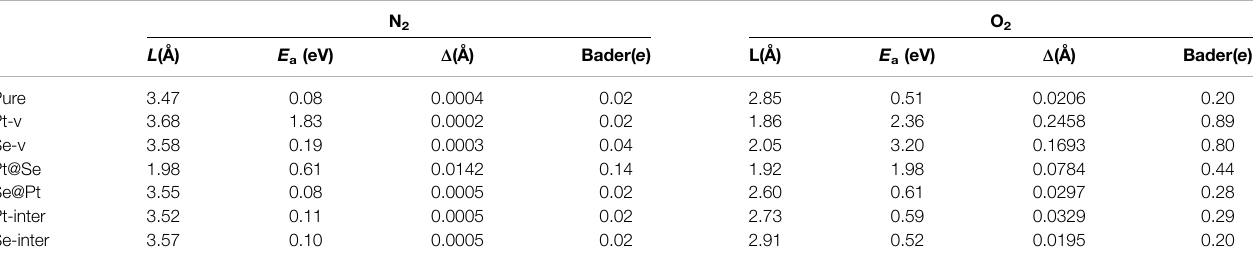
TABLE 1 | Adsorption distance L (in Å), the absorption energy E a (in eV), the change in the molecular bond length Δ (in Å) upon adsorption, and the values of Bader charges on molecules for the various adsorption structures.